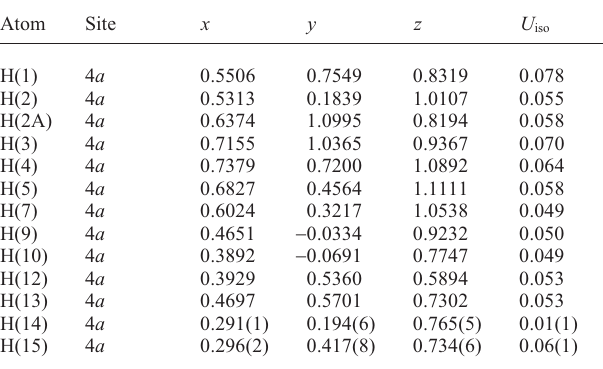
N *** H–Ointer-molecularhydrogenbonds.Allbondlengthsinthe compound are consistent with normal values. Table 2. Atomic coordinates and displacement parameters (in Å 2 )